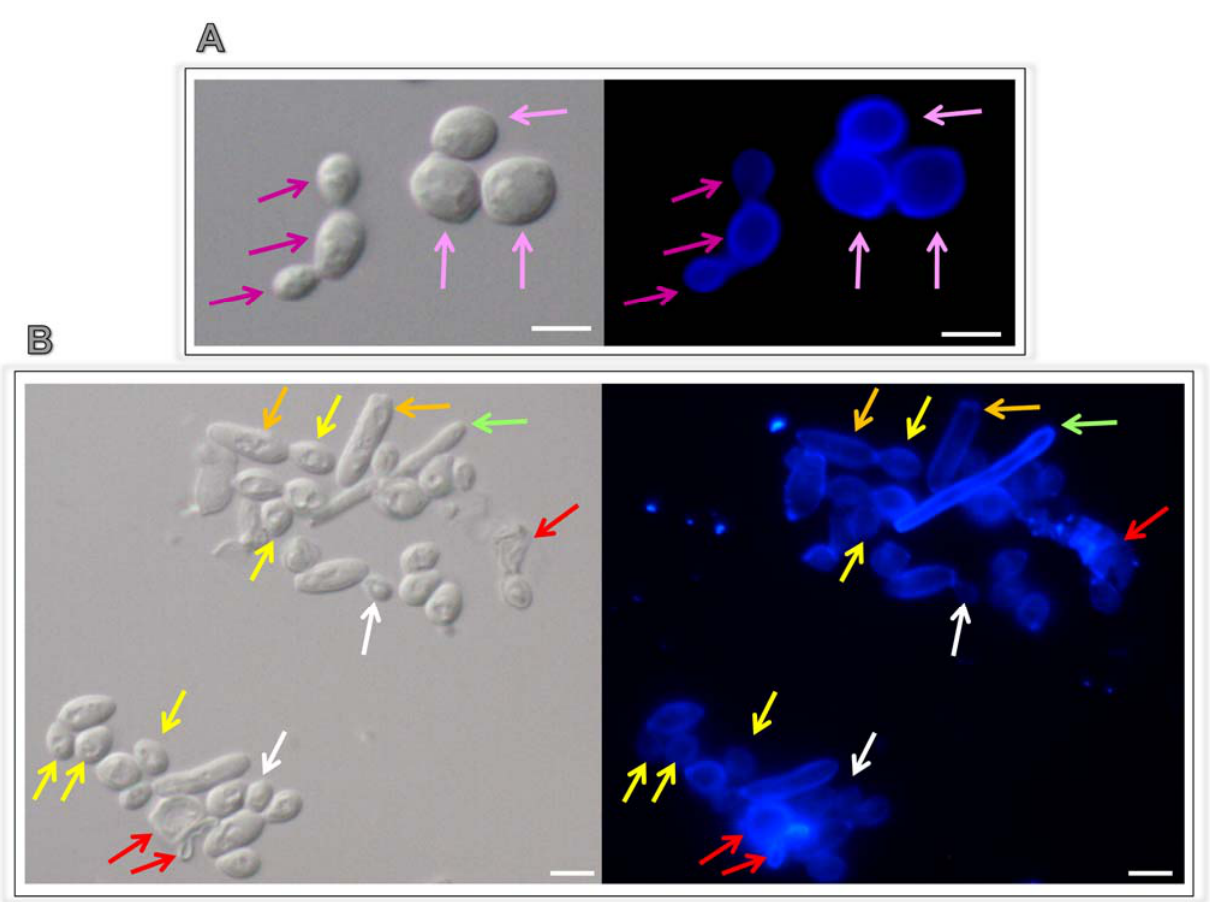
Figure 3. Light and fluorescent microscopy images exemplifying the morphological differences observed in C. albicans cells grown in YCB-BSA medium in the absence ( A ) and in the presence of 200 µM lopinavir ( B ) for 20 h. The control cell population is homogeneous and consists of rounded yeast cells (light pink arrows) and pseudohyphae (dark pink arrows). Contrarily, the treatment with lopinavir induces some clear morphological alterations, including petite cells (white arrows), smaller and ovoid cells (yellow arrows), large non-ovoid cells (orange arrows) and ghost or lysed cells (red arrows), as well as some small hyphae (green arrow) were observed. Bars = 5 µm.